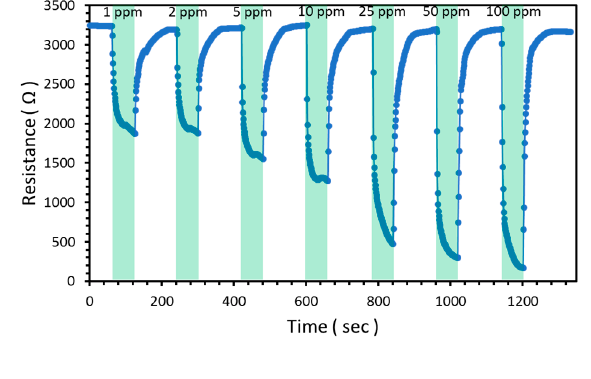
Sensors 2019 , 19 , x FOR PEER REVIEW 8 of 10 The responses to 100 ppm CO, NH 3 , and NO 2 of at temperatures ranging from 100 to 350 °C in 50 °C increments are shown in Figure 11a and Table 3. Likewise, the response to CO was higher than those to NH 3 and NO 2 at all temperatures. The highest response to these gases was observed and the difference between the responses to three gases was the greatest at 300 °C. In Figures 10 and 11, although the response to NH 3 improved by the addition of α -Fe 2 O 3 , the response to CO remained higher. Figure 11b shows the resistance change of the gas sensors at 100 °C. ( a ) ( b ) Figure 11. Response of ZnO NW vines decorated with 0.05 M α -Fe 2 O 3 to 100 ppm CO, NH 3 , and NO 2 : ( a ) according to temperature from 100 to 350 °C, ( b ) at 100 °C. Table 3. Response of ZnO NW vines decorated with 0.05 M α -Fe 2 O 3 at various temperatures. The response of the NW vines decorated with 0.05 M α -Fe 2 O 3 at concentrations of CO ranging from 1 to 100 ppm was measured at 300 °C. R g became lower as the concentration of CO gas increased